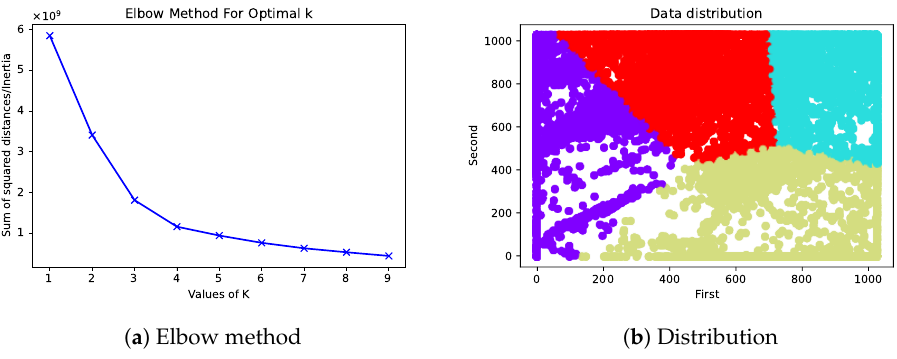
Figure 11. Total squared distance for a value of k from 1–9 and the distribution for 50,000 states with a value of k = 4 for two value attributes of the distance